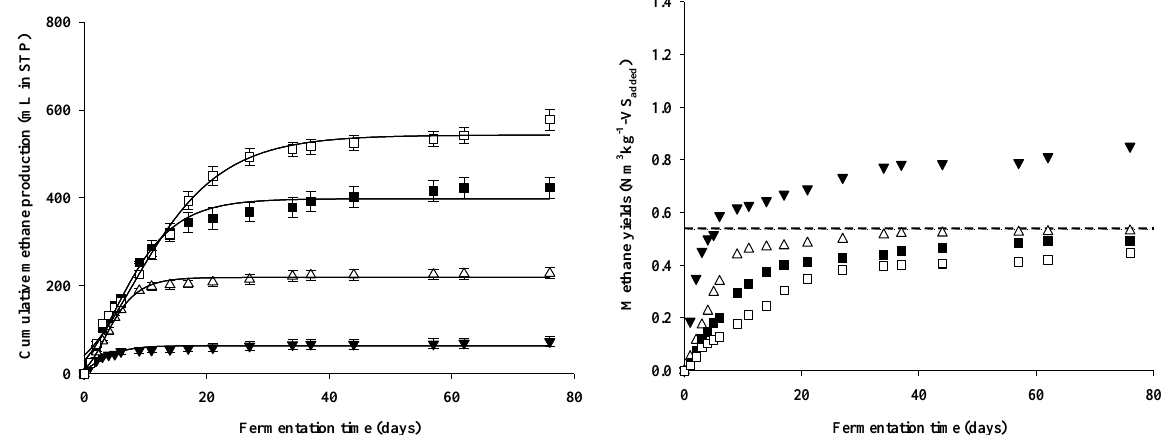
Figure 1. Cumulative methane production and yield from blood during batch anaerobic digestion at different S/I ratios. ▼,  , ■, and □ indicate substrate to inoculum (S/I) ratios of 0.10, 0.50, 1.00, and 1.50, respectively, and --- is B th (0.539 Nm 3 /kg-VS added ). Vertical bars indicate standard